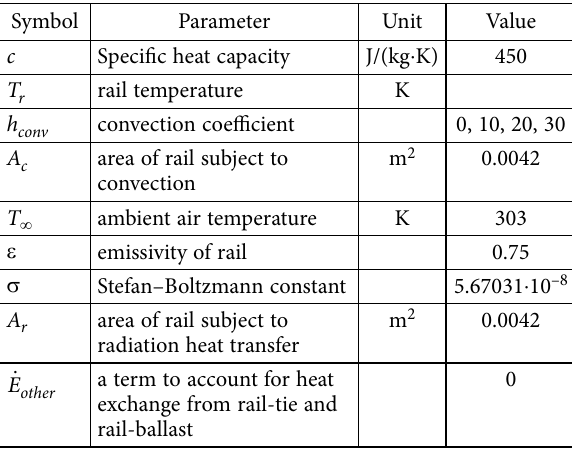
Table 10. Values for the environmental